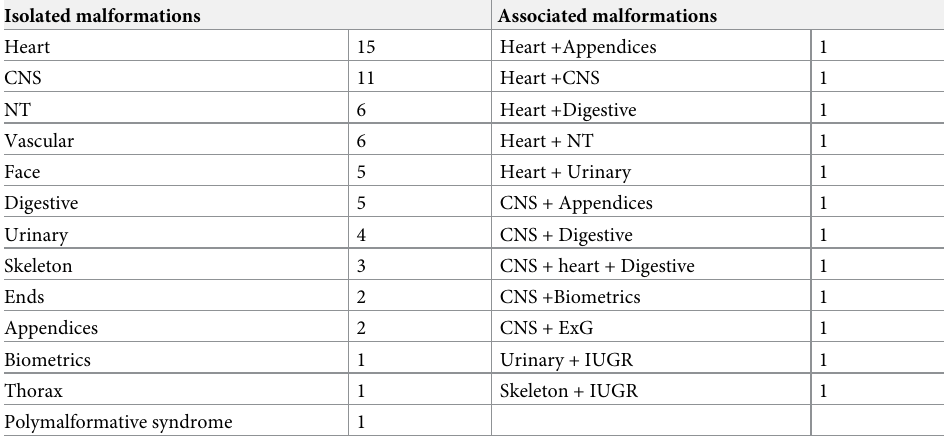
Table 3. Distribution of malformations detected by type of device